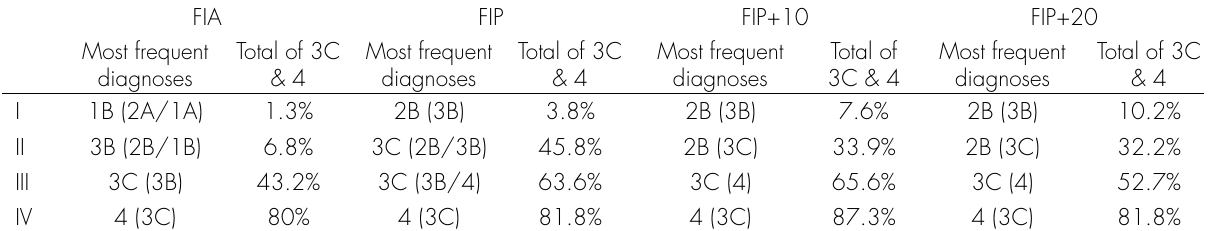
Table IV. Summary of the most often-detected diagnoses and the sum of the total percentages of 3C and 4 diagnoses in each study group and topographic